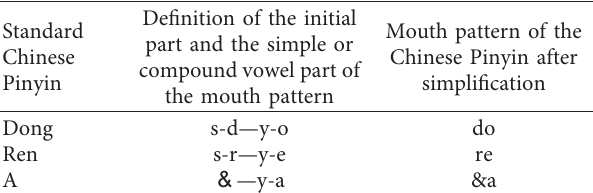
Table 3: Examples of the conversion of some Chinese